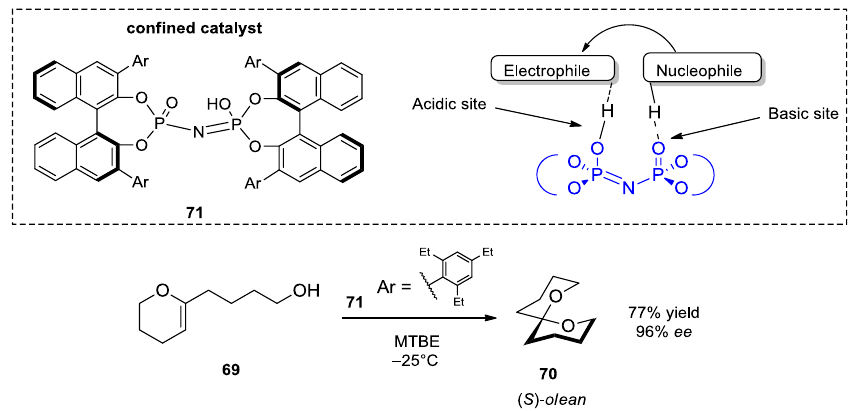
Figure 17. The asymmetric spiroacetalization reaction catalyzed by con fi ned Brønsted acids (BAs); bifunctional con fi ned catalysts ’ pocket, from Ref.